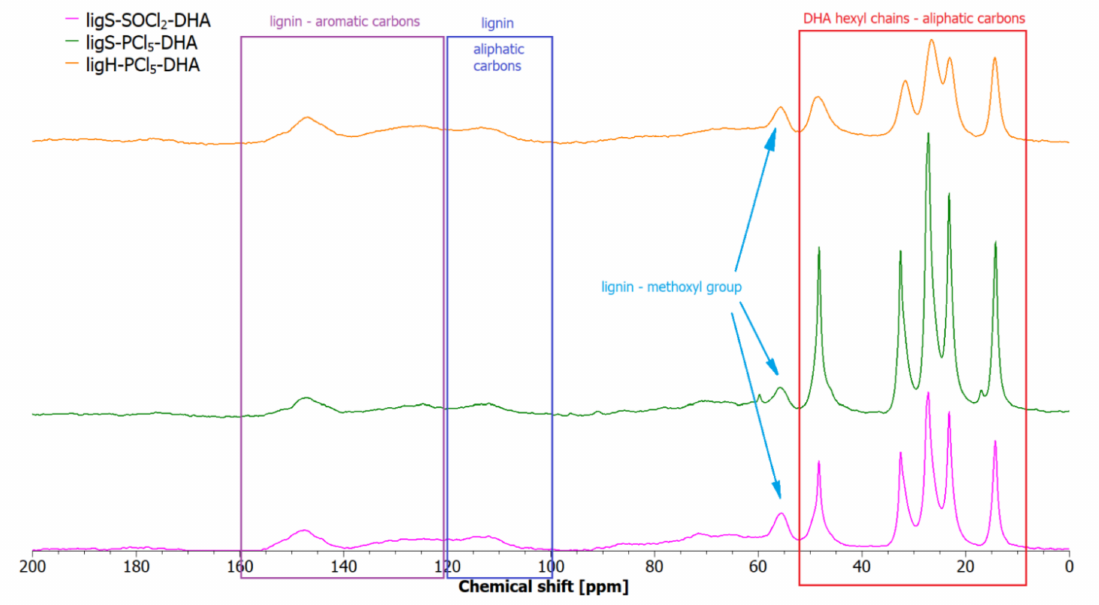
Figure 3. Solid-state 13 C NMR spectra of the lignin materials after the second step of